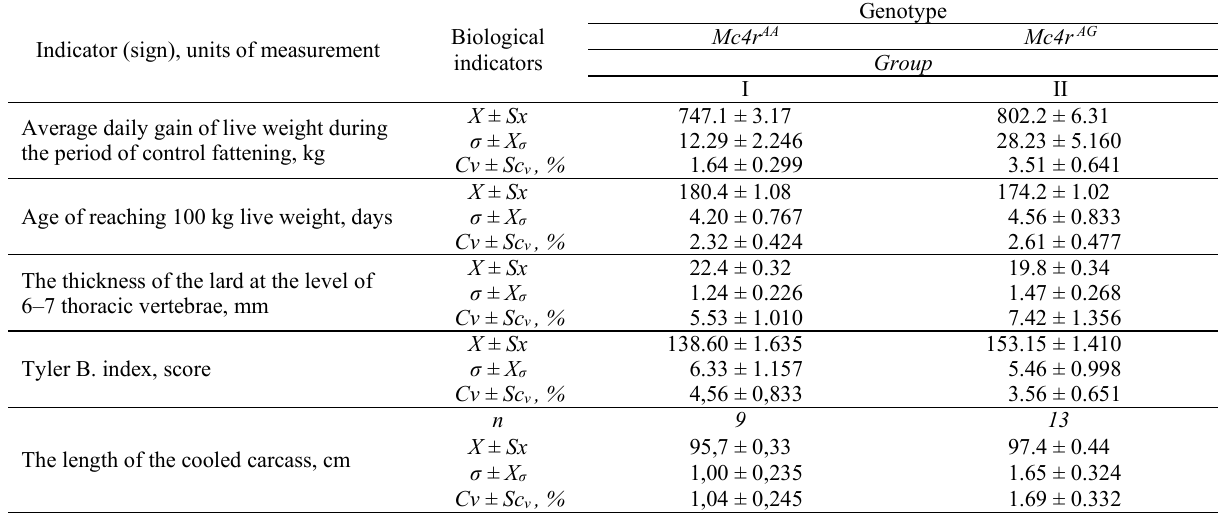
Feeding and meat qualities of young pigs of different genotypes according to the melanocortin receptor gene 4 ( Mc4r ), n = 15